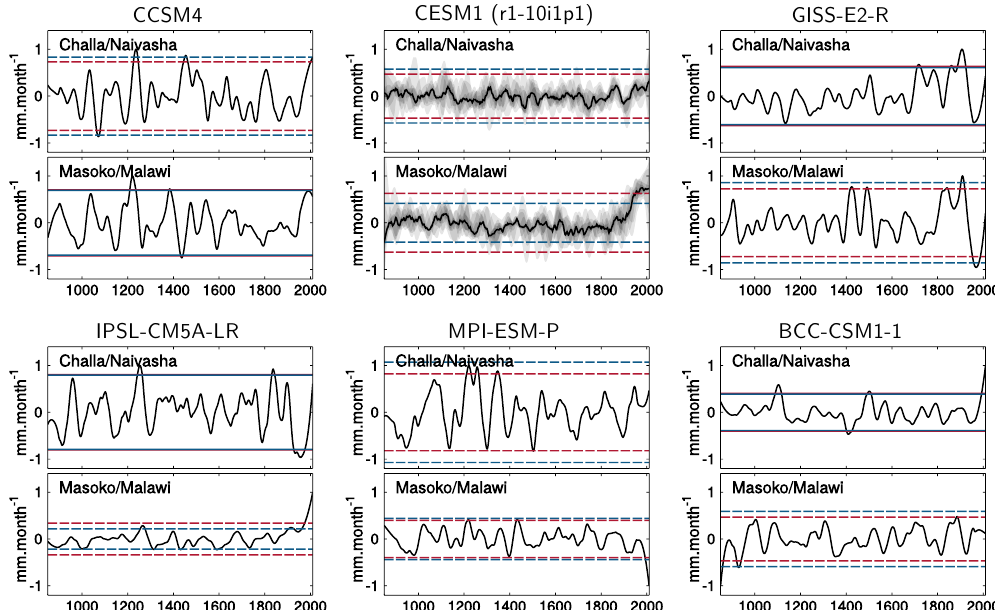
Figure 9. Simulated time series of P - E (black lines) over the Challa–Naivasha and Masoko–Malawi regions throughout the last millennium (850–2005). Results are mean annual values smoothed using a loess filter with a window of 100 years, and are presented as anomalies with respect to the entire period. The horizontal red lines are displayed on both sides of the zero line at two times standard deviation of the smoothed time series. The horizontal blue lines also represent 2 standard deviations on both sides of zero but based on the time series from pre-industrial control simulations. The horizontal lines are dashed if the variance of the simulation with time-varying forcing is significantly different ( F test, considering a 5% level) from the variance of the simulation with fixed forcing; if not, it is solid. For the CESM1 model, the black line is the median of the 10 ensemble members, while their range is shown in grey